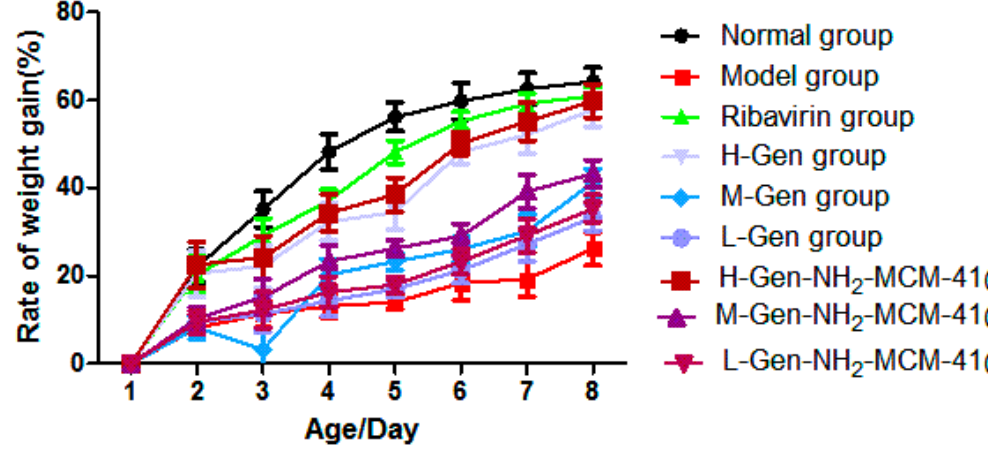
Figure 17. The body weight change in suckling mice in different groups.